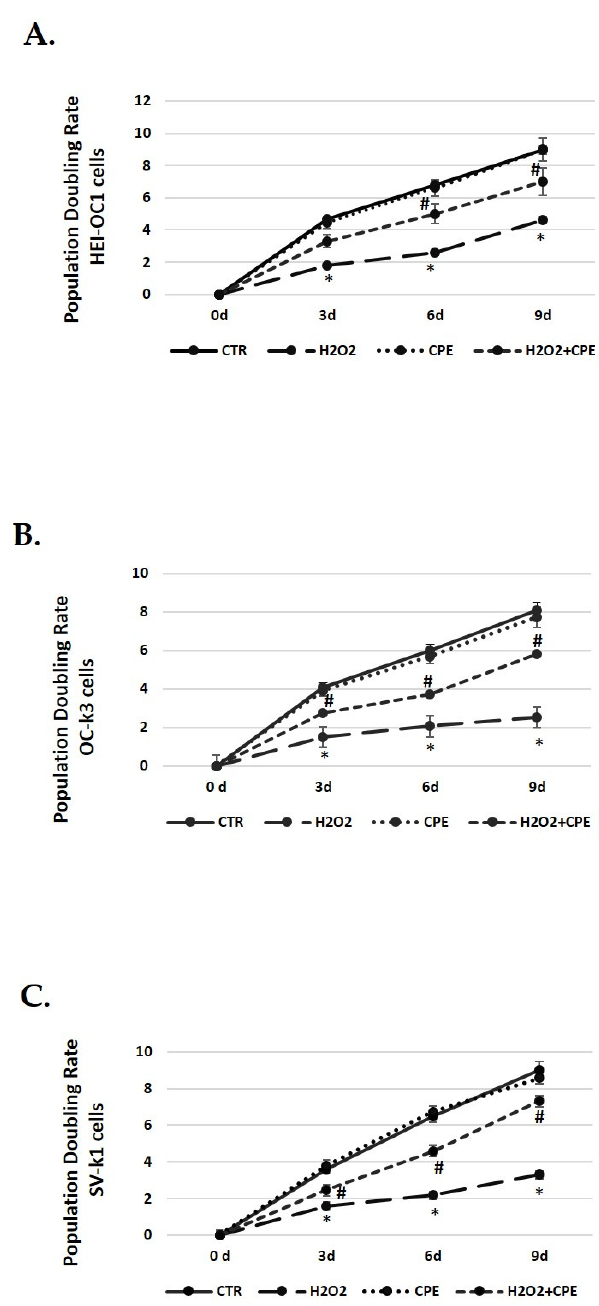
Figure 3. Population doubling rate post CPE treatments increase in auditory senescent cells. Pop- ulation doubling experiments were performed post-treatments in auditory cell lines. Experimental groups: CTR group (0 and 5 µ g/mL of CPE for 20 h) and H 2 O 2 (CPE-pre-treatment at 0 and 5 µ g/mL for 20 h and H 2 O 2 -post-treatment at 100 µ M for 1 h). Data are means ± SD (n = 3). * p < 0.05 vs. of CTR group (0 µ g of CPE); # p < 0.05 vs. H 2 O 2 group (0 µ g of